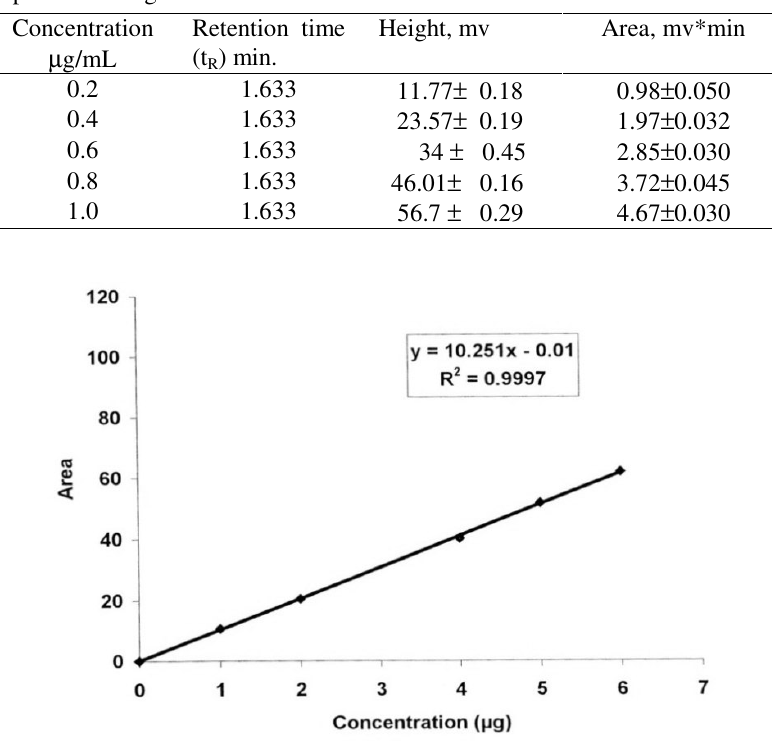
Figure 2 . Calibration curve of alprazolam standard powder Measurement of the active ingredient